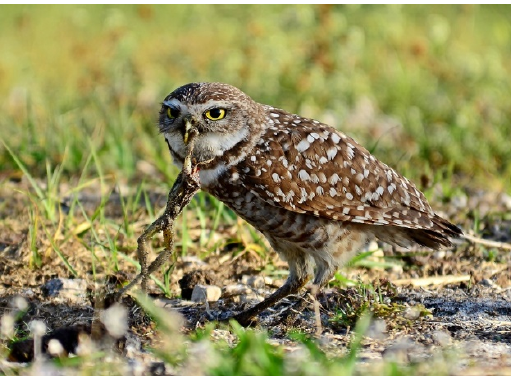
Figure 9. Burrowing Owl eating a frog at Fort Lauderdale, FL [70].